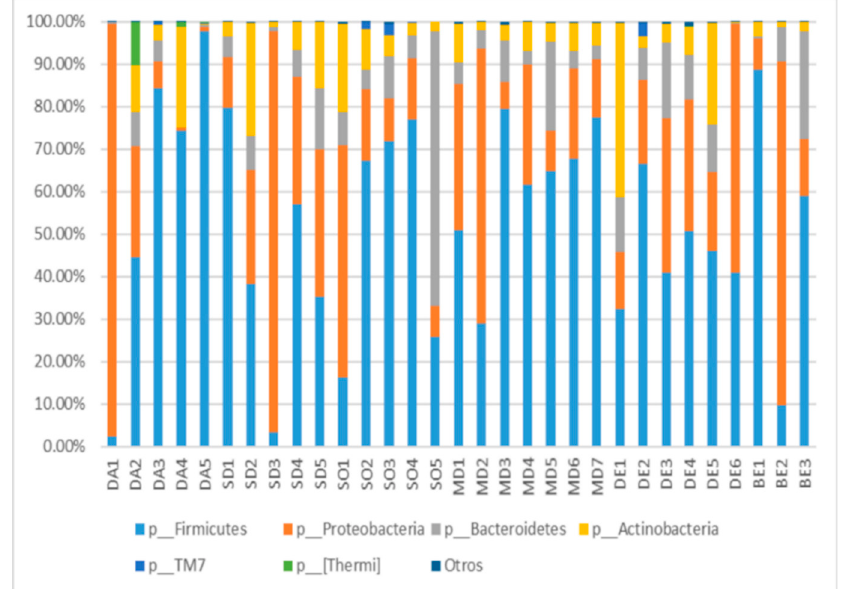
Figure 1. Relative abundance of bacterial phyla in the ready-to-eat dishes. The figure shows a bar graph of relative abundance with the most abundant bacterial phyla in the ready-to-eat dish samples. The phyla are identified with colors as shown below the graph. Others include the phyla Gemmatimonadetes, Synergistetes, and Lentisphaerae. DA, dairy product; SD, side dishes; SO, soups; MD, main dishes; DE, deserts; BE,